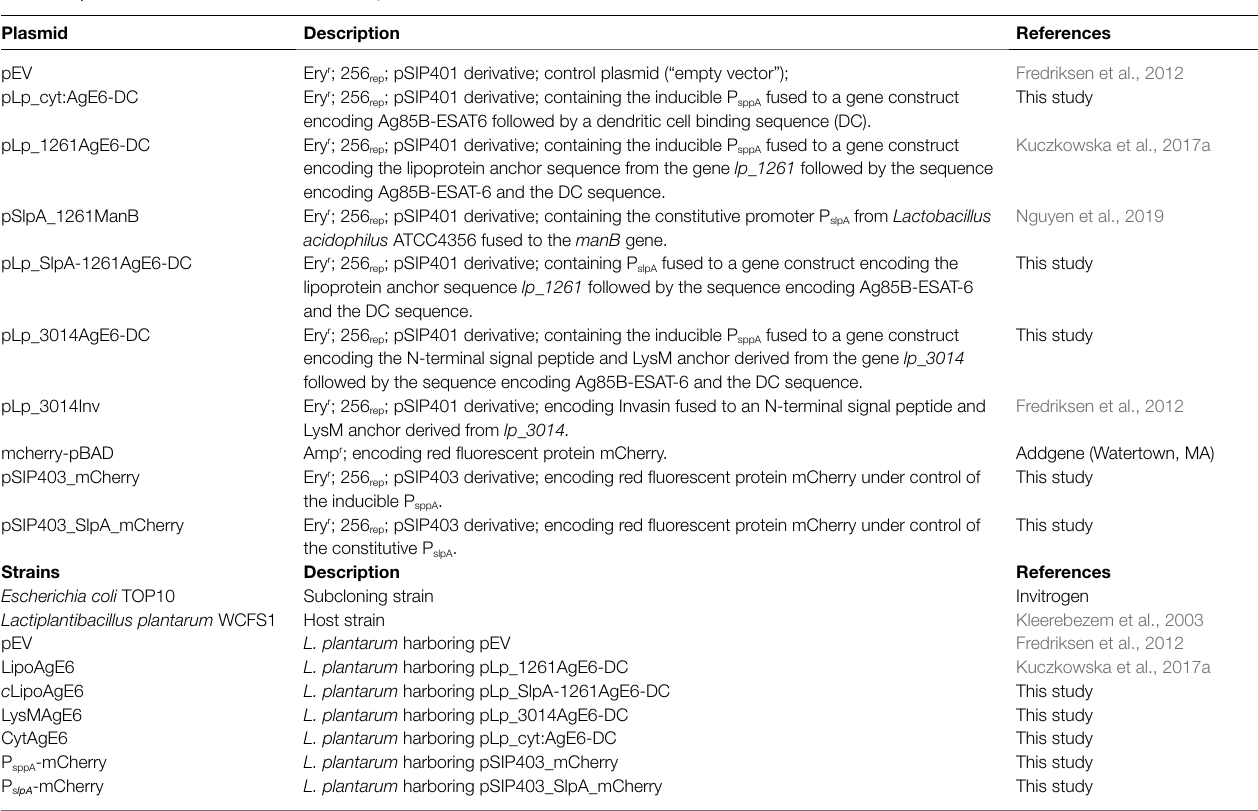
TABLE 1 | Plasmids and strains used in this study.